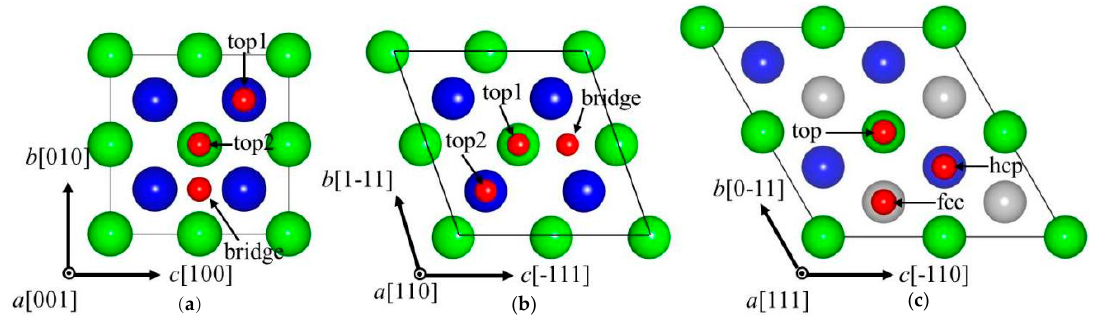
Figure 5. Top view of ( a ) 2 × 2 W (100), ( b ) 2 × 2 W (110), and ( c ) 2 × 2 W (111) surfaces (all seven layers). Large green, blue, and gray spheres are for the surface, subsurface, and third layer W atoms, respectively. Small red spheres correspond to the X (X = C, N) atom absorbed at three different sites.